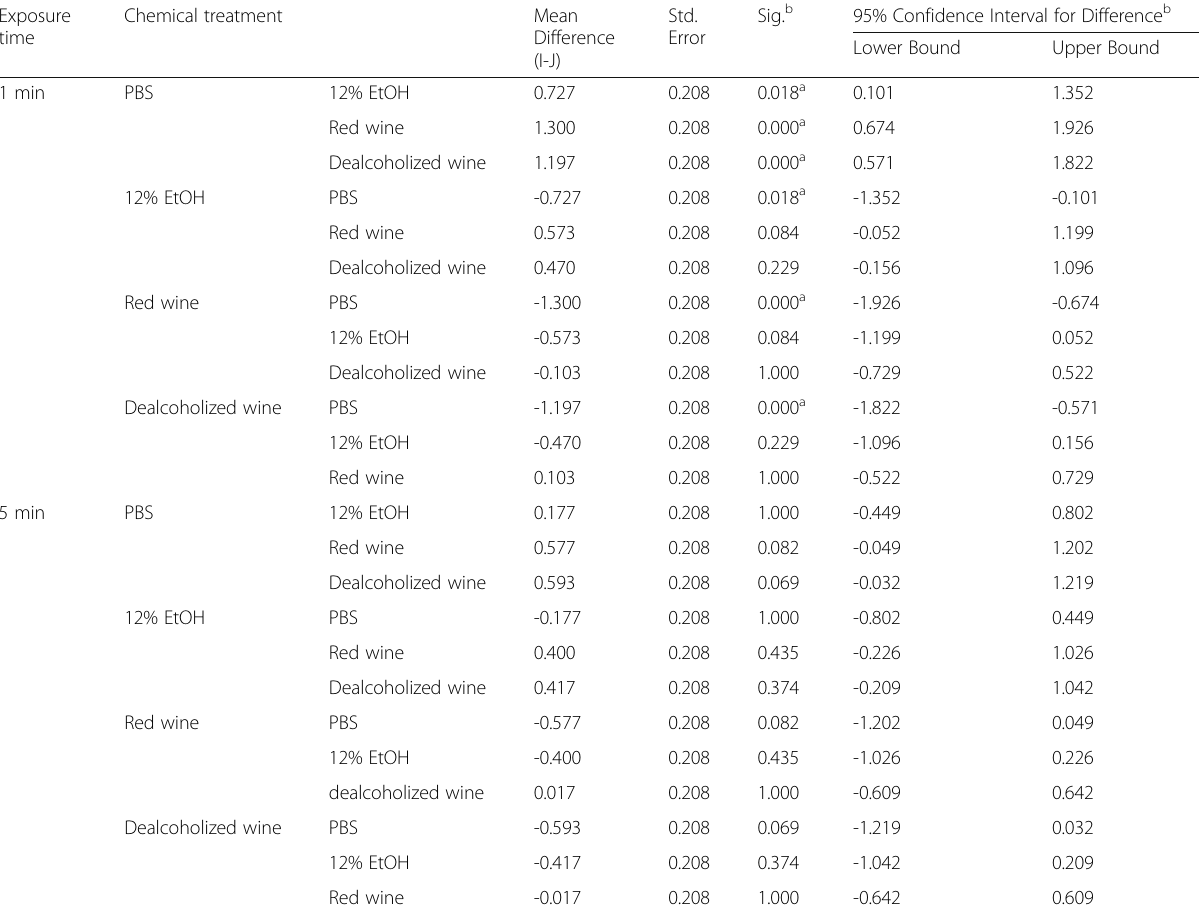
Table 2 Effect of red wine and dealcoholized red wine on the live/dead cell ratio (i.e. the area occupied by living cells divided by the area occupied by dead cells) of the whole biofilm obtained by Confocal Laser Scanning Microscopy (CLSM). PBS: phosphate buffer saline, EtOH: ethanol Exposure